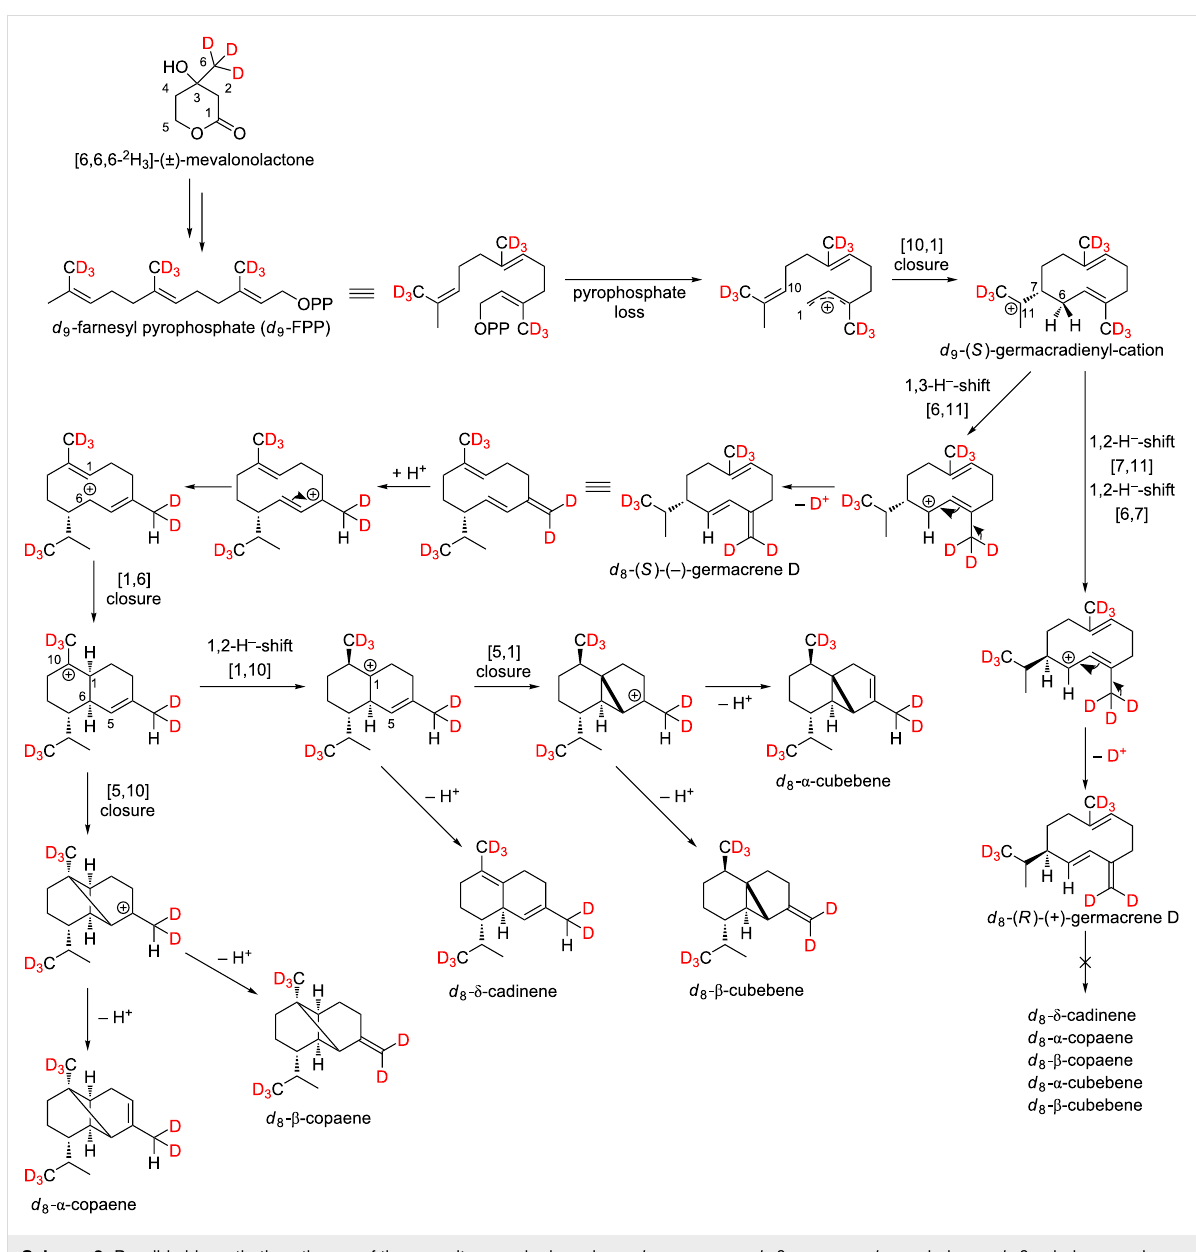
Scheme 2: Possible biosynthetic pathways of the sesquiterpene hydrocarbons d 8 - α -copaene, d 8 - β -copaene, d 8 - α -cubebene, d 8 - β -cubebene and d 8 - δ -cadinene. As a stable isotope-labeled precursor, d 3 -MVL was added to isolated exocarp of ripe grapes of the Lemberger grape